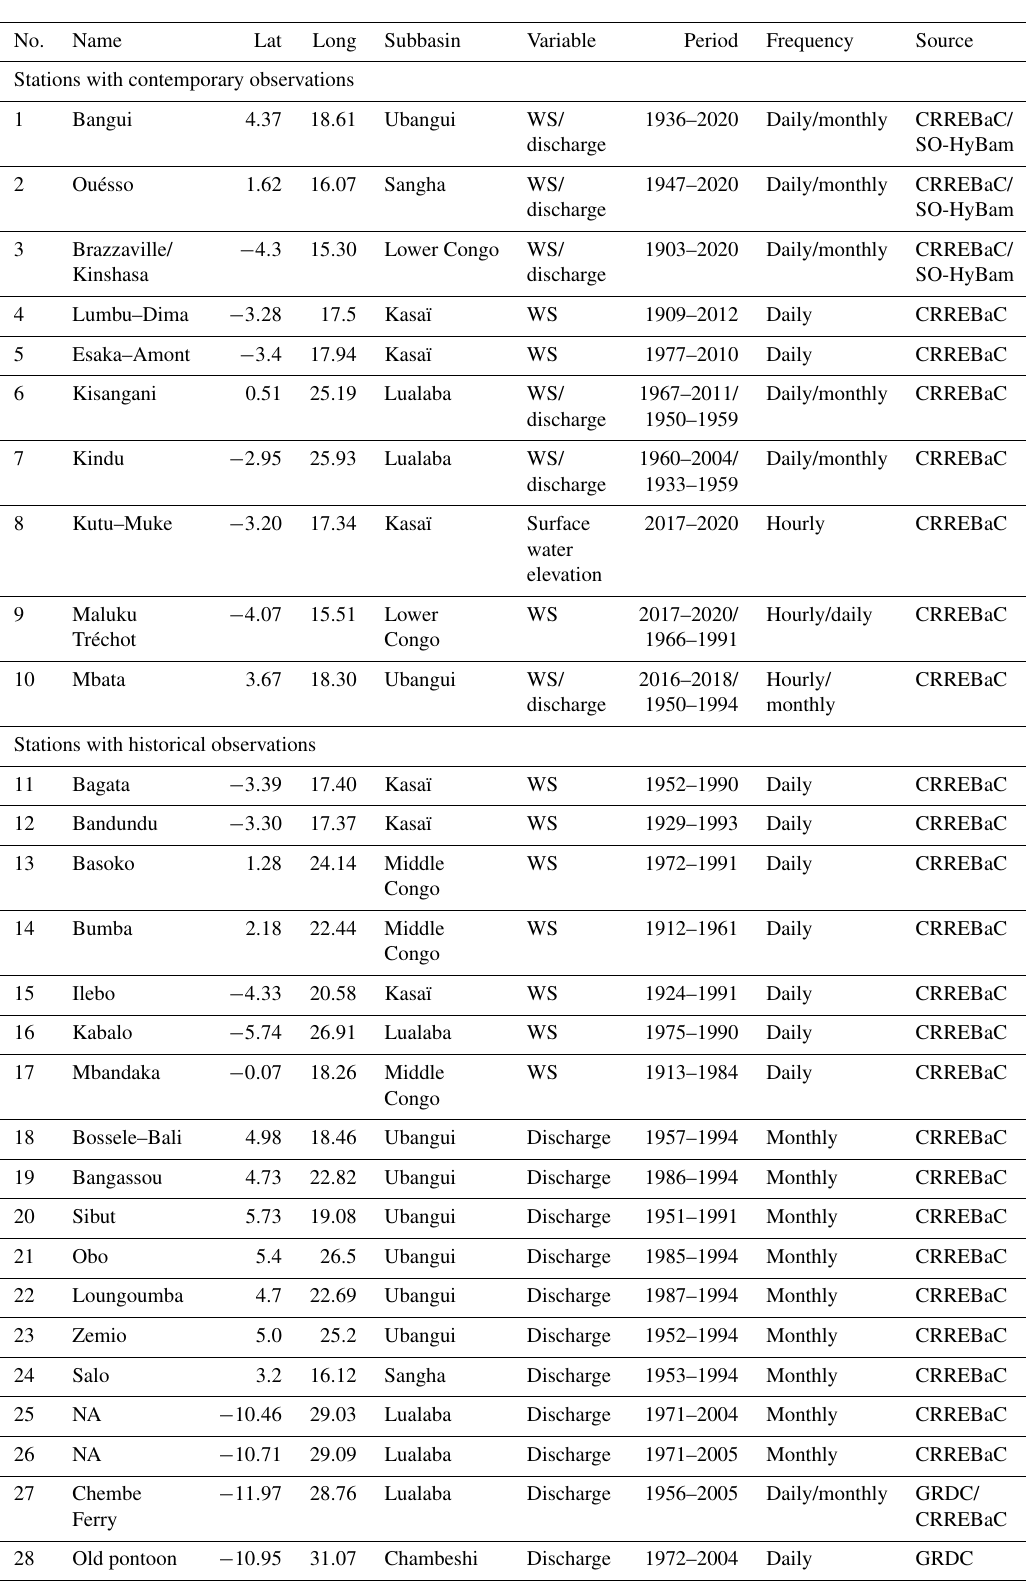
Table 1. Location and main characteristics of in situ stations used in this study. The locations are displayed in Fig. 1. WS is the water stage.